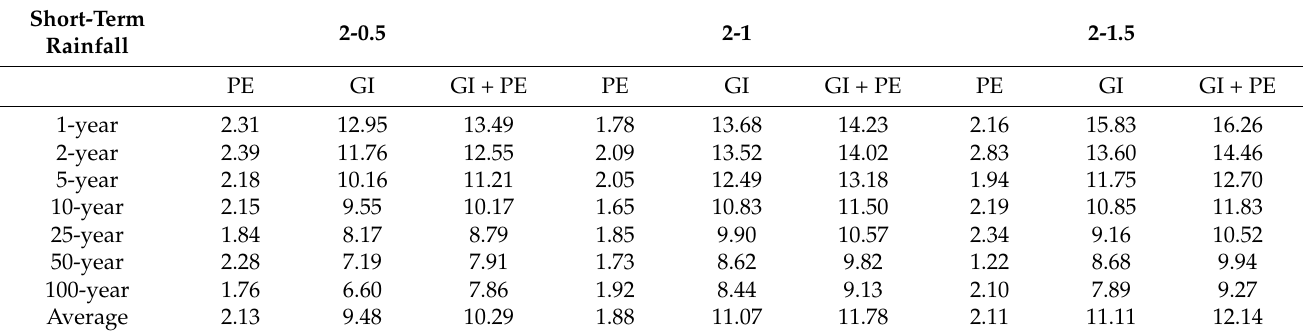
Table 4. Average reduction rate of road inundation in long-term